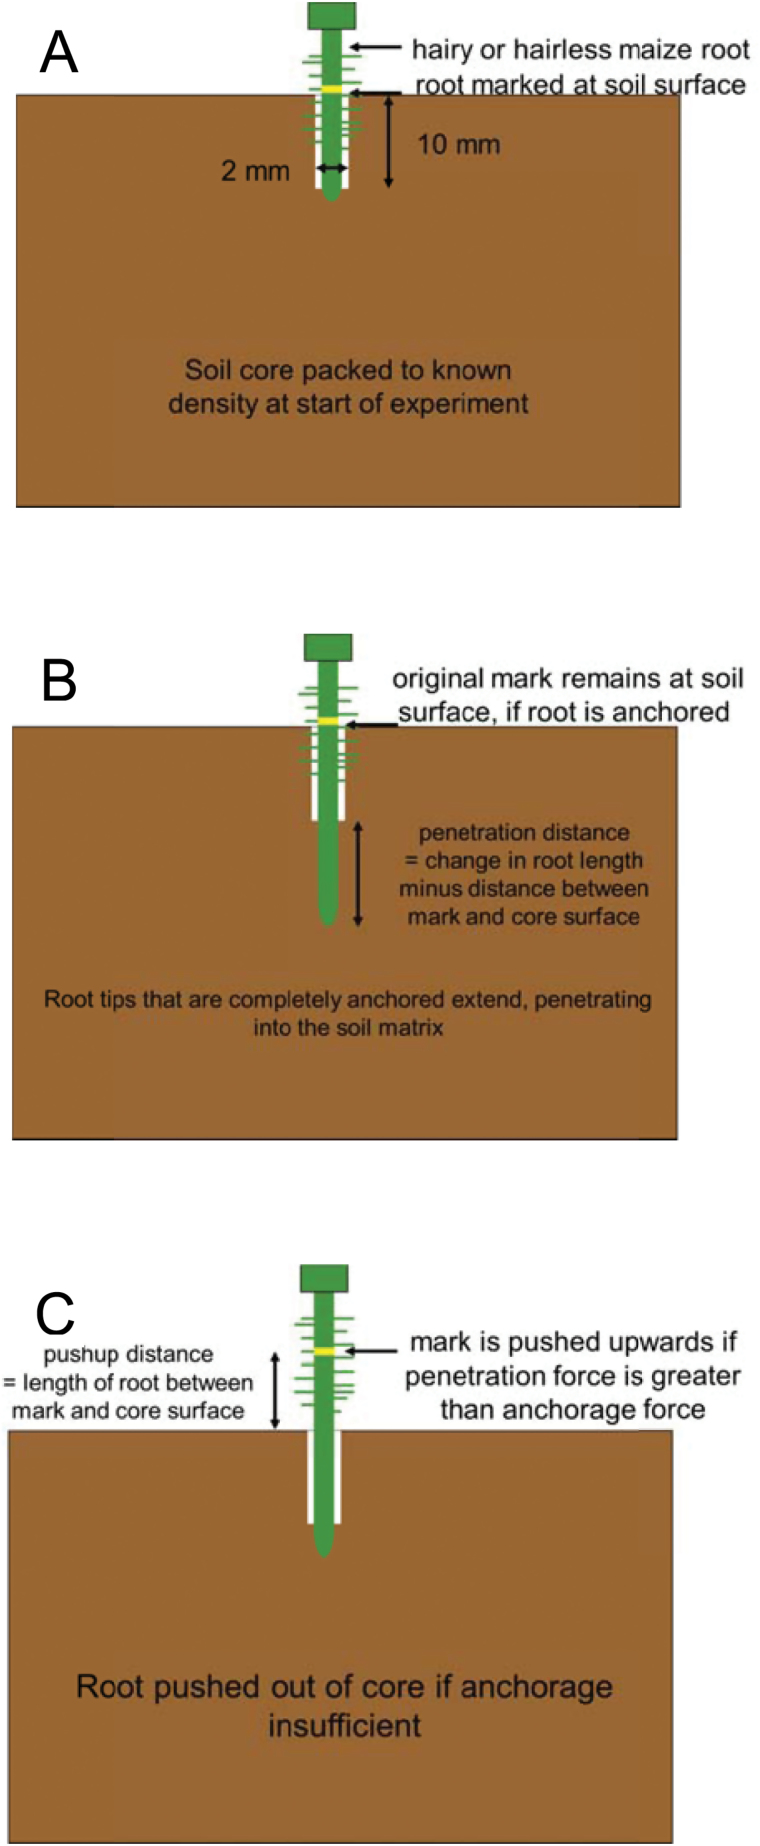
Schematic diagram (Experiment 2) showing the experimental set-up to study root anchorage during root growth from an artificial cylindrical biopore into bulk soil. (A) Initial setup. (B) Illustration showing a root that anchors itself in the biopore, enabling the root tip to penetrate further into the soil. (C) Illustration showing a root that does not anchor itself in the soil and so penetrates only a very short distance into the soil, with the majority of root extension directed out of the soil.